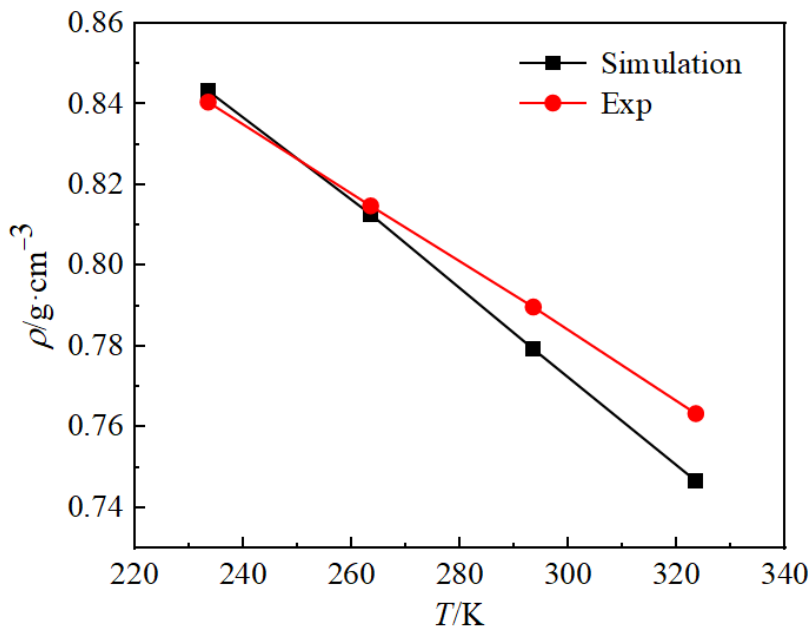
Figure 6. The simulated and experimental values of density of liquid C 2 H 5 OH at different tempera- tures.